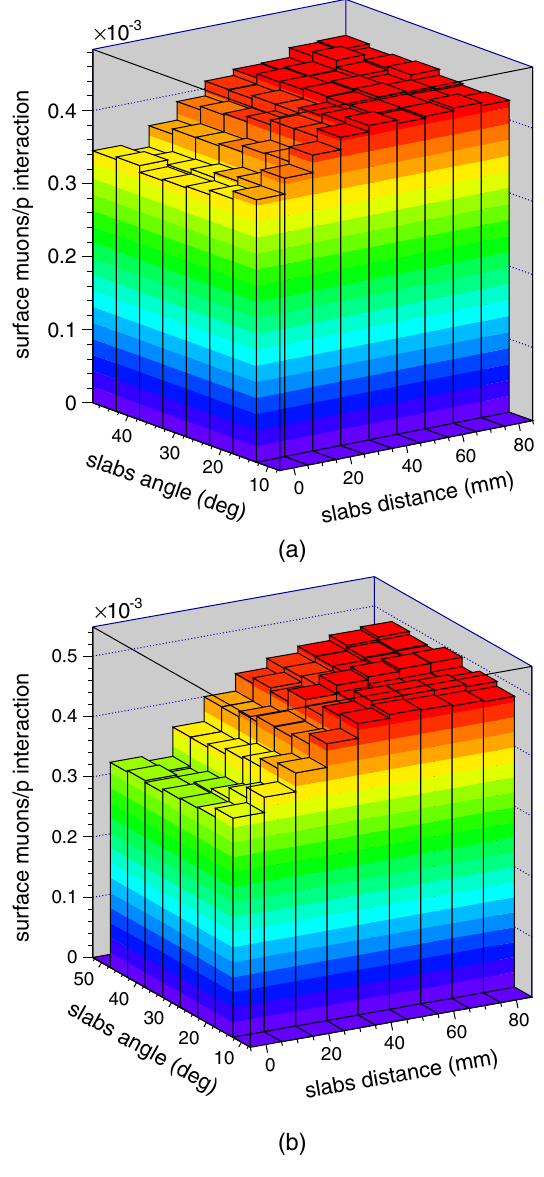
FIG. 4. Variation of the surface muon yield with distance between the slabs and slab angle orientation. (a) The two-slabs design case. (b) The three-slabs design case.